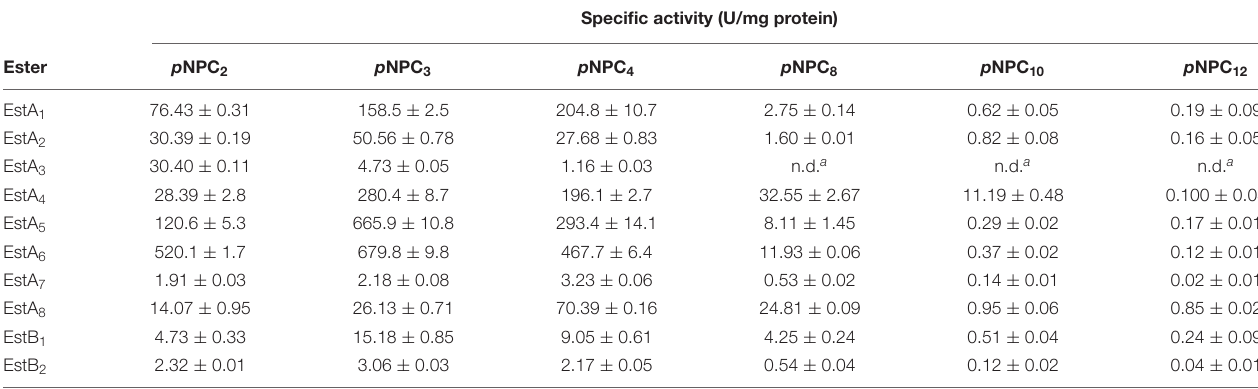
TABLE 2 | Specific activity (U/mg pure protein) for each of the enzymes tested over a set of p-nitrophenyl ( p NP) esters of different lengths. Specific activity (U/mg protein)